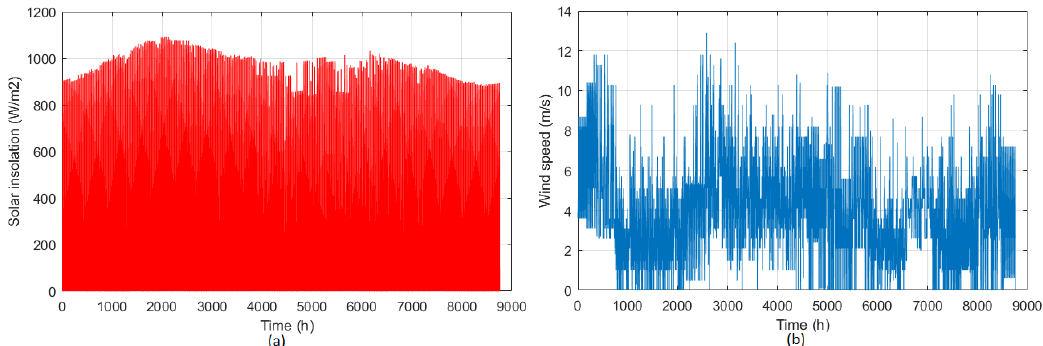
Figure 4. The hourly profiles of solar irradiation ( a ) and wind speed ( b ) at Fanisau.